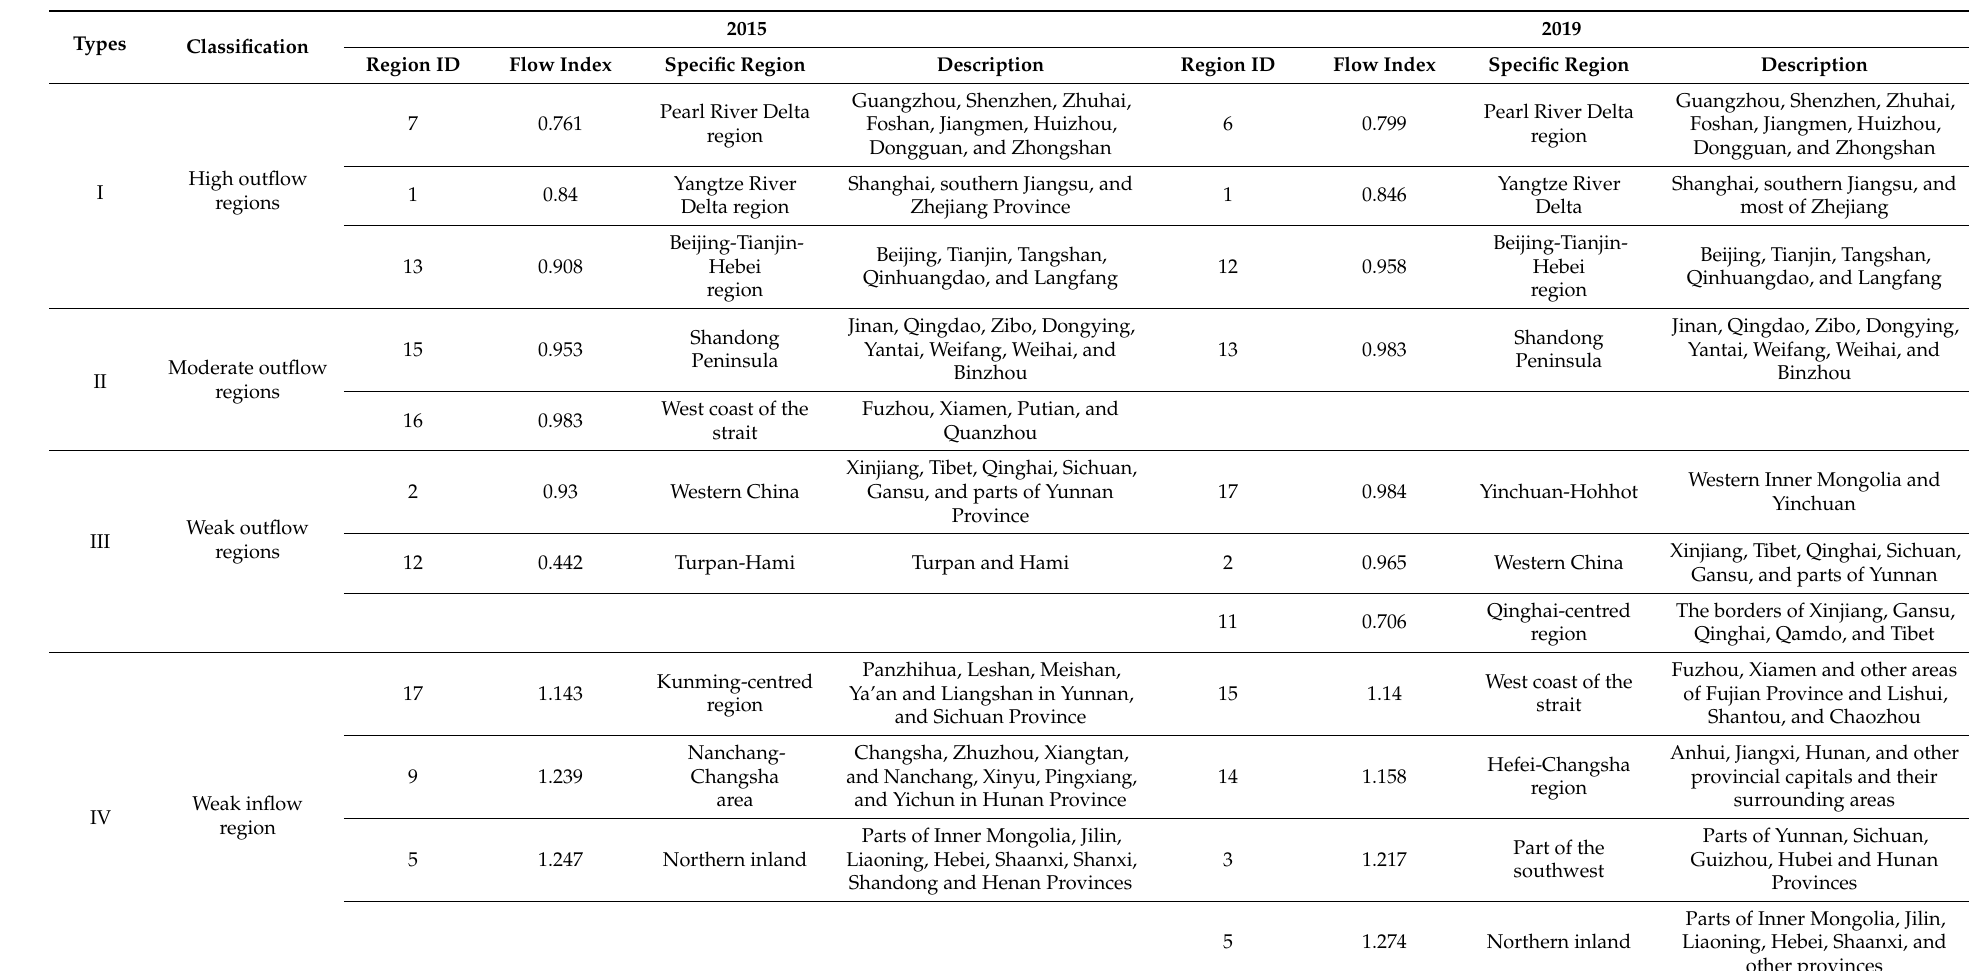
Table 1. Classification of the source and sink areas of population flow during the Spring Festival travel